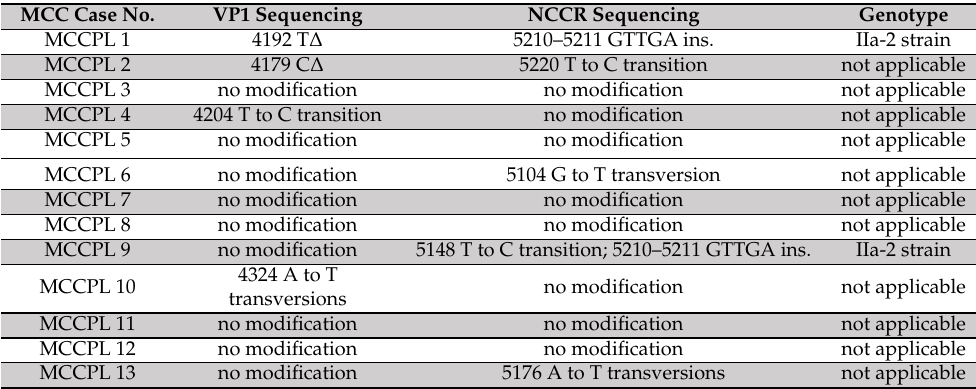
Table 2. Analysis of VP1 and NCCR sequencing in MCCPL and MCCML